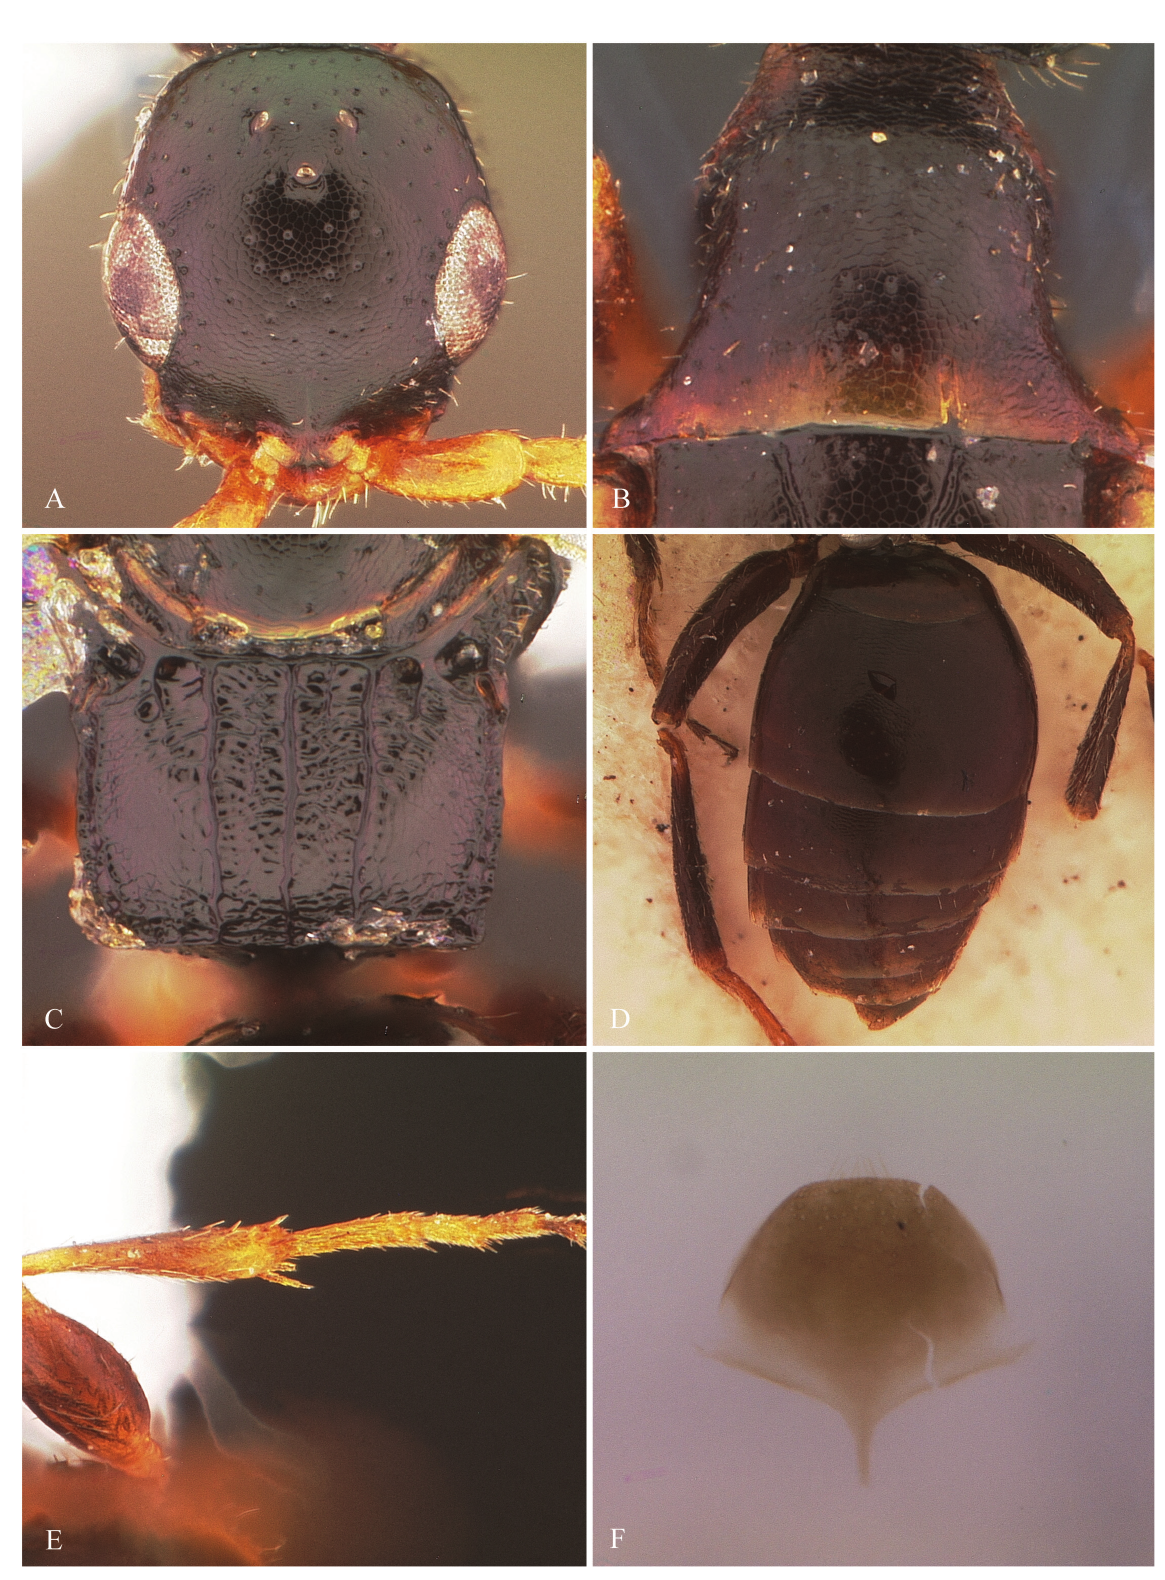
Fig. 1. Diagnostic characters of Bradepyris . A . Head in dorsal profile. B . Pronotal disc. C . Propodeal disc. D . Metasoma in dorsal profile. E . Mesotibia. F .